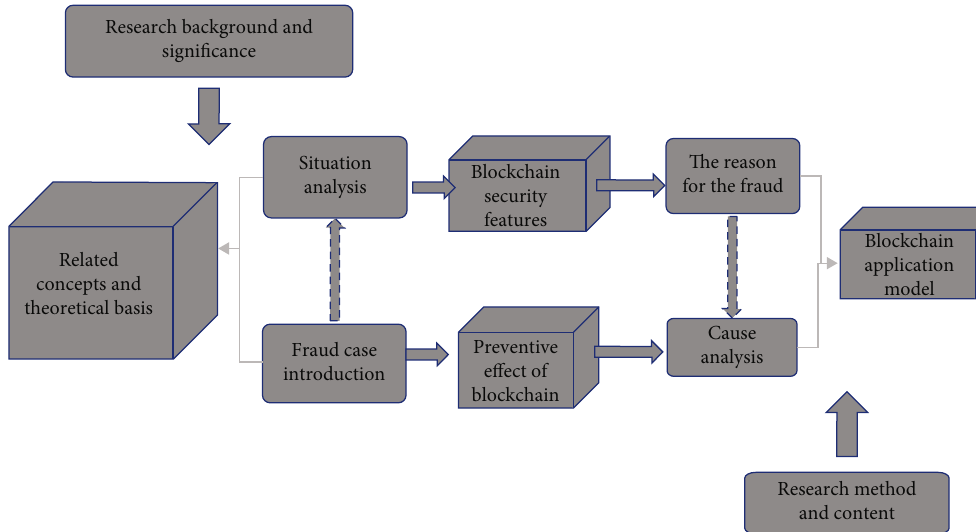
Figure 1: The process of blockchain technology to prevent fi nancial fraud